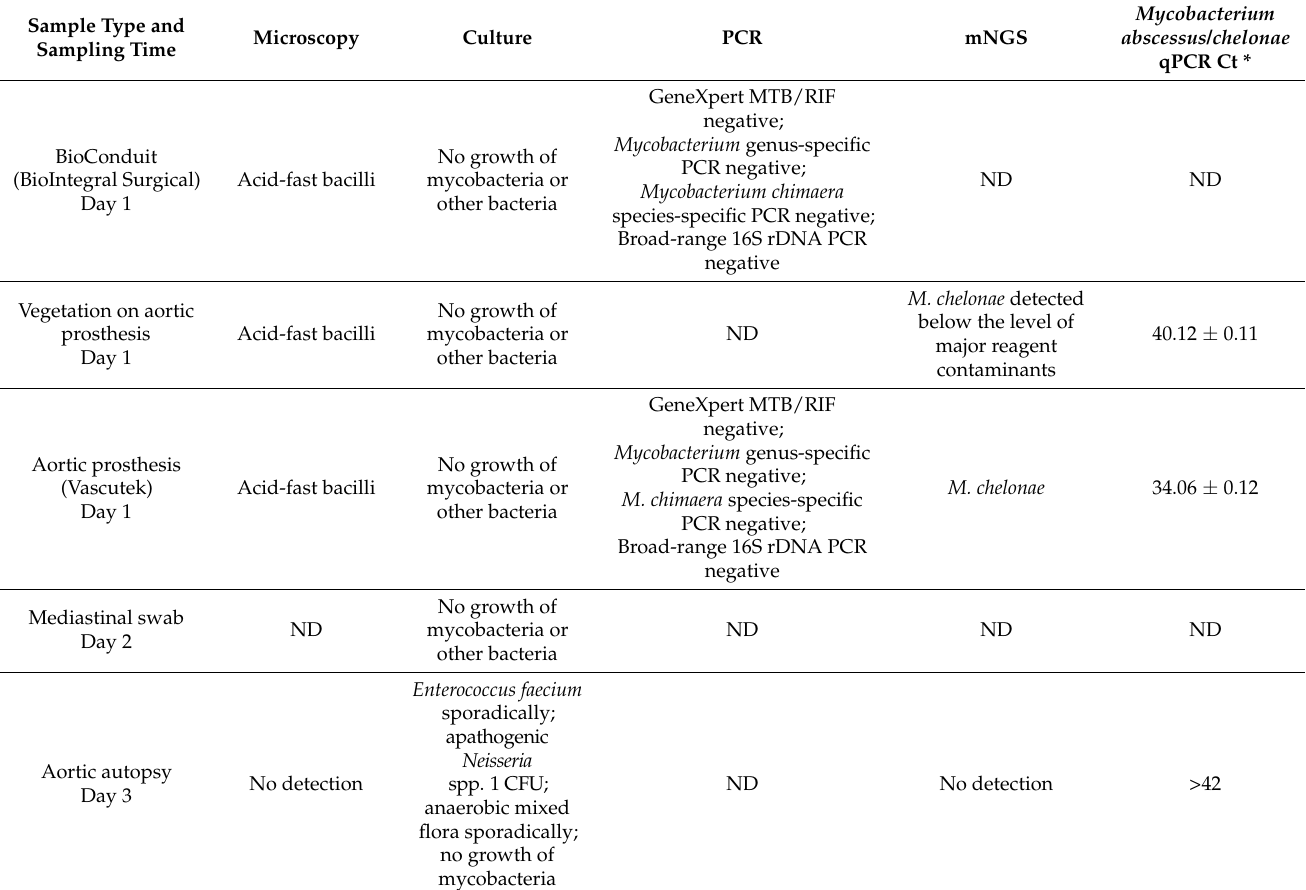
Table 1. Summary of microbiological, molecular and mNGS